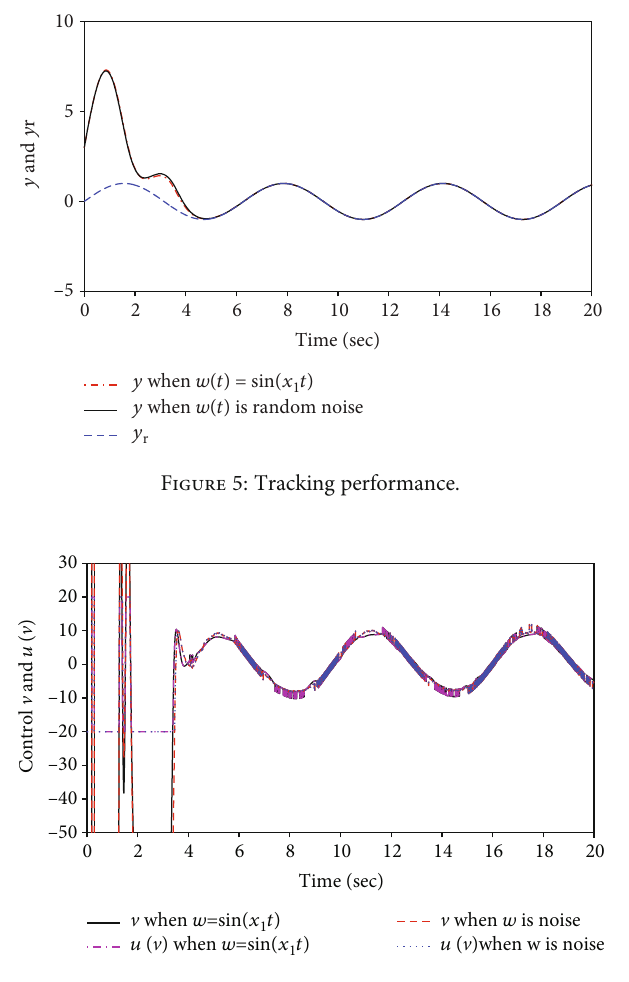
Figure 6: Control signal.